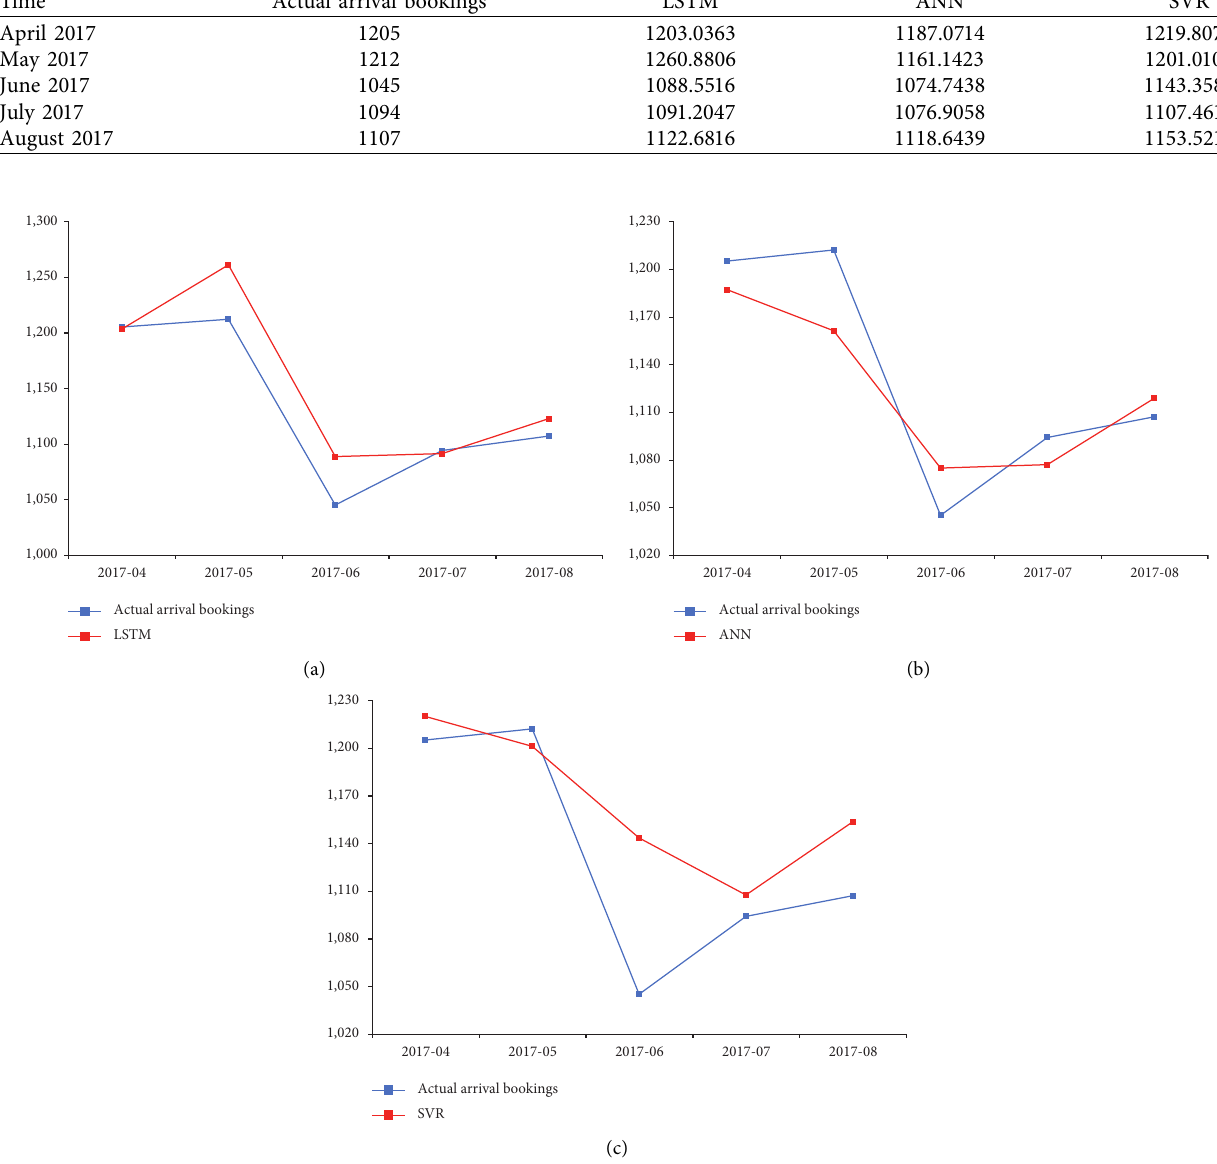
Figure 5: Comparison of the fitting curves of each model in testing